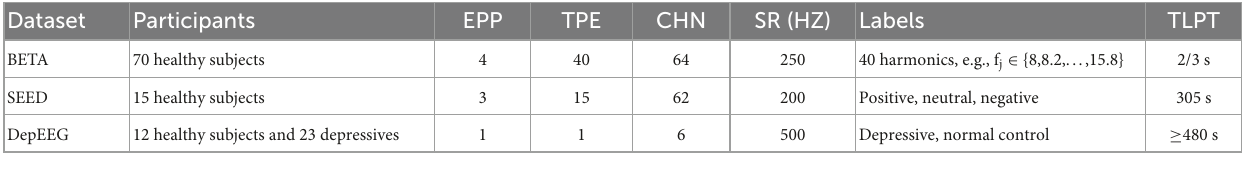
TABLE 1 Detail information on the three datasets.